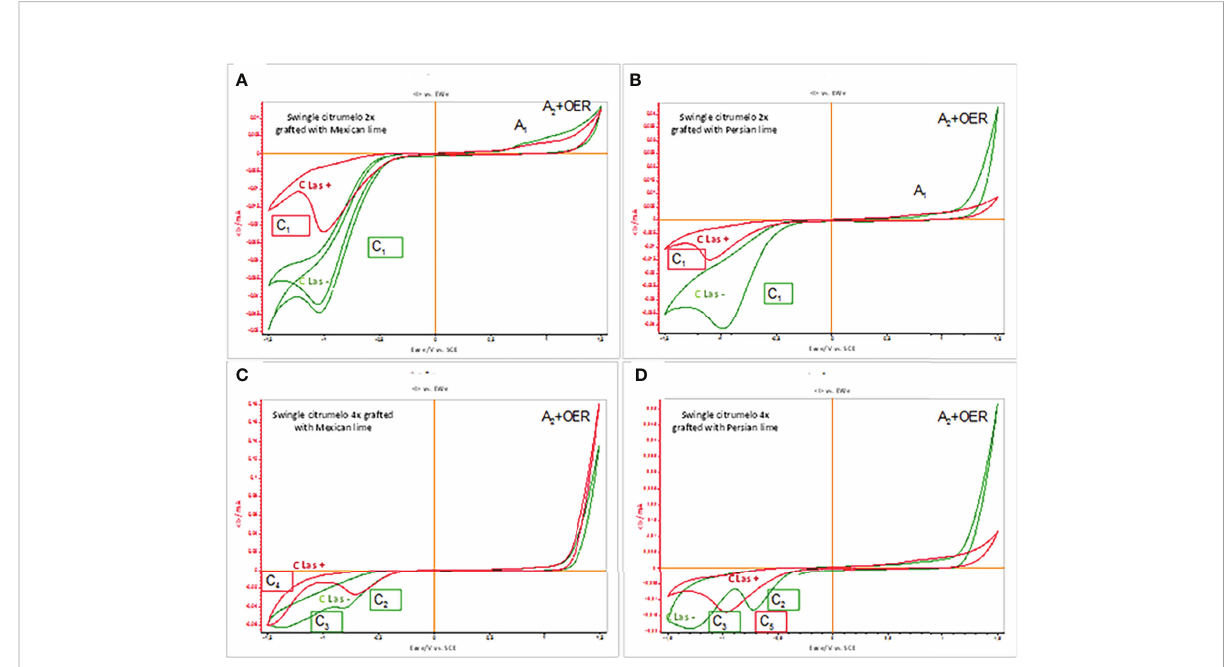
FIGURE 5 CV pro fi les of 2x or 4x roots of Swingle citrumelo rootstocks grafted with Mexican lime or Persian lime infected (CLas+, red curves) or not (CLas-, green curves). (A) Mexican lime/2x Swingle citrumelo; (B) Persian lime/2x Swingle citrumelo; (C) Mexican lime/4x Swingle citrumelo; (D) Persian lime/4x Swingle citrumelo. Potential scan initiated at 0.0 V in the negative direction; potential scan rate 10 mV s − 1